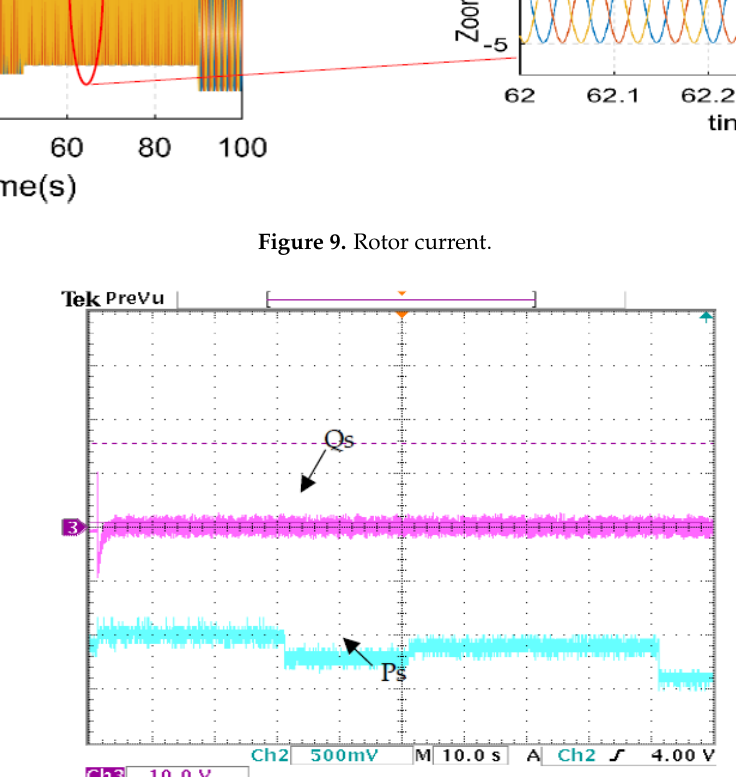
Figure 10. Active and reactive power.